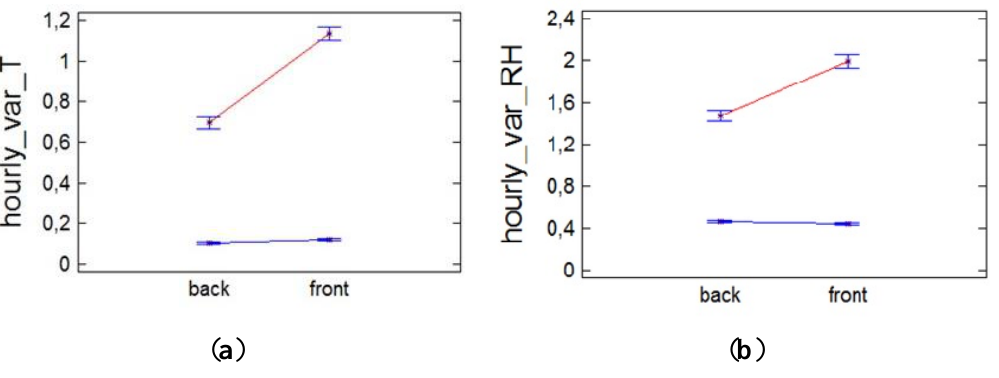
Figure 5. Interaction plot of the factor climate control system (blue = OFF, red = ON) and orientation (B/F), for the ANOVA analysis of the hourly variation of ( a ) temperature, ( b ) RH.